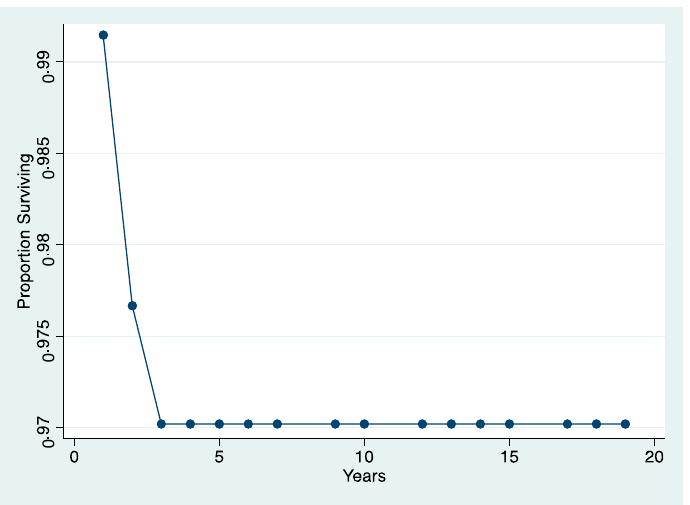
Figure 4. The survival rate after 18 years was 97.3% (Interval of Confidence (IC) 95.1–98.3). All of the extractions, except, one occurred during the first 2 years of service.